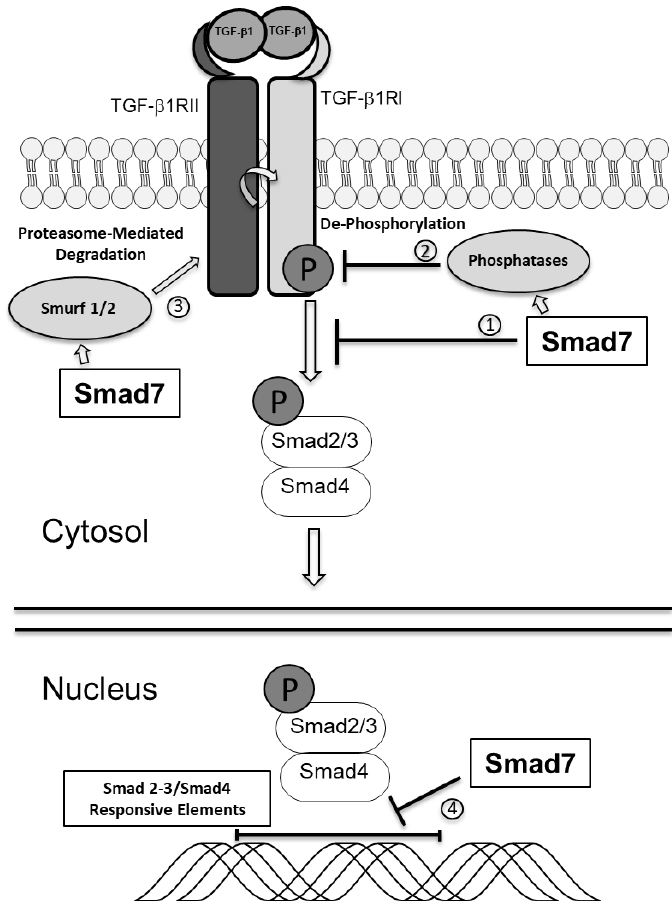
Figure 1. Smad7 negatively regulates TGF- β 1 signaling through various mechanisms: 1. binding to T β R1 prevents Smad2/3 phosphorylation; 2. de-phosphorylation and inactivation of T β R1 through recruitment of phosphatases; 3. interaction with E3 ubiquitin ligases SMURF1/2 to promote proteasome-mediated degradation of T β R1; 4. in the nucleus, through inhibition of the association of the Smad2-3/Smad4 complex with specific Smad-responsive DNA